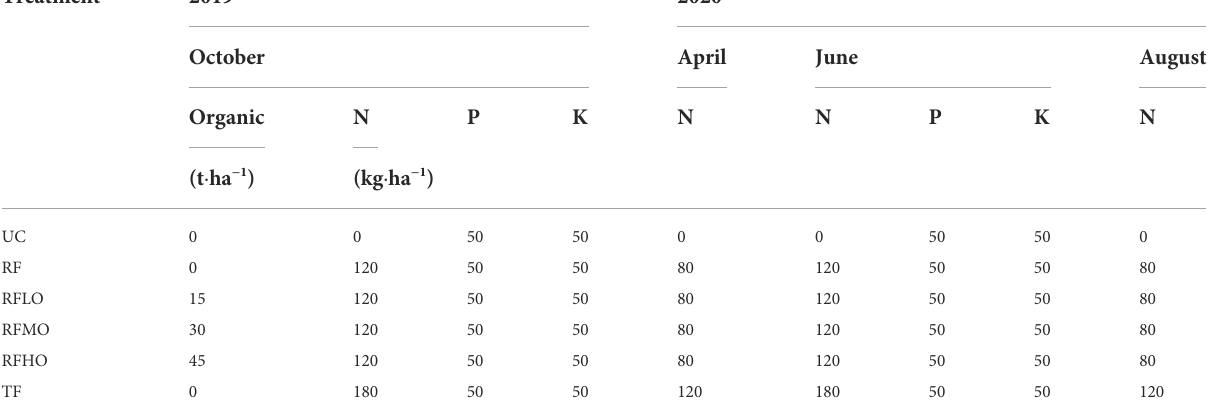
TABLE 1 Application rates of fertilizers under different fertilization treatments.